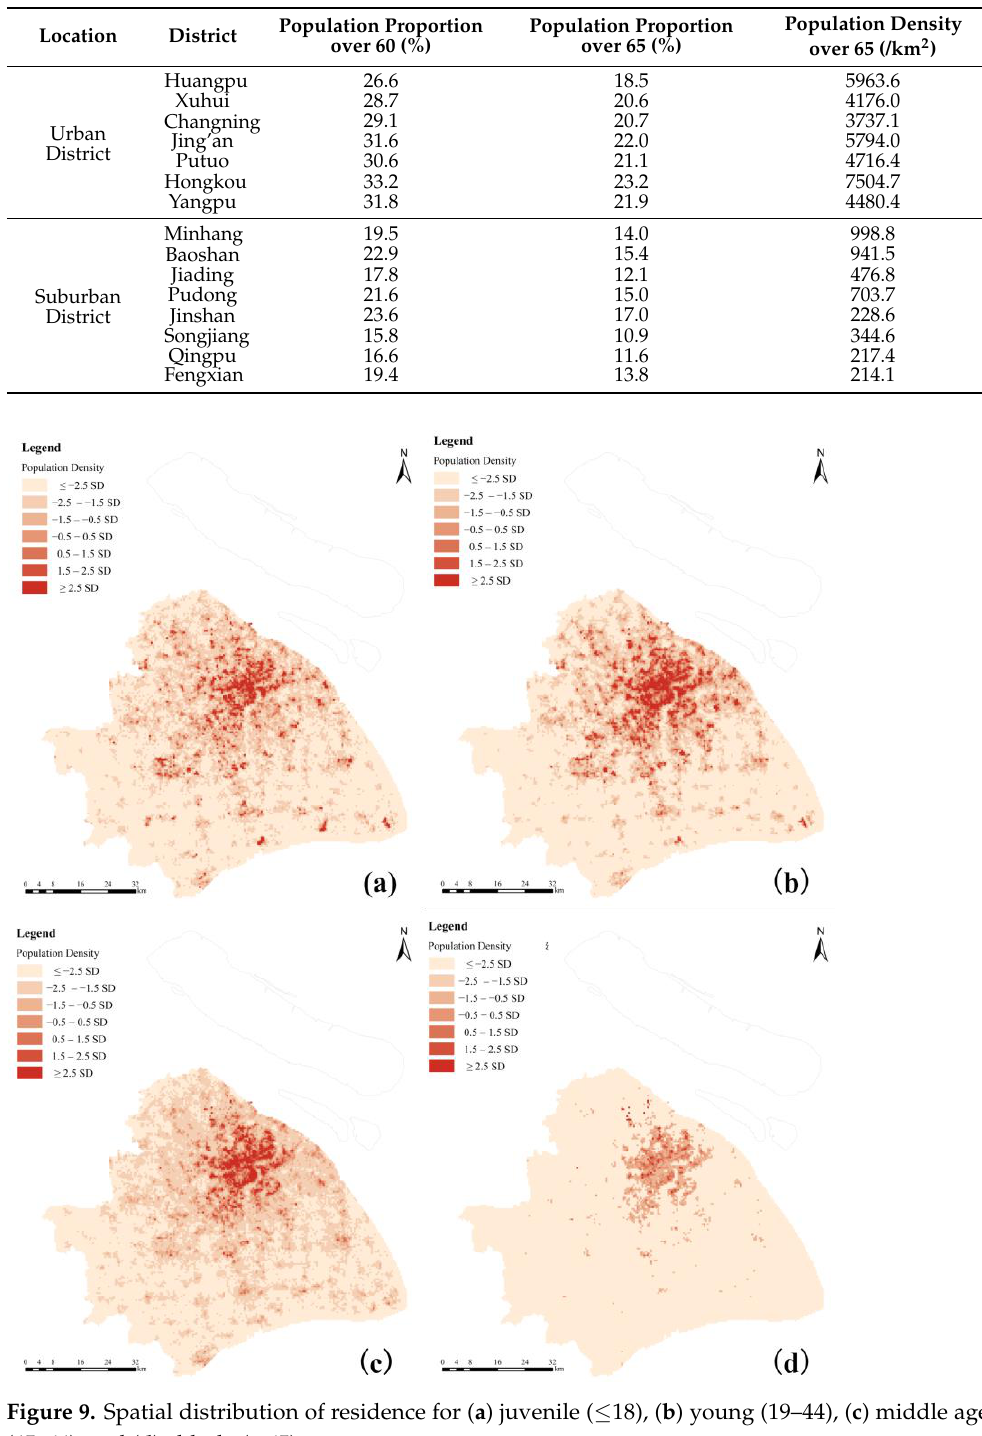
Table 10. Population Aging Level in the districts of Shanghai.